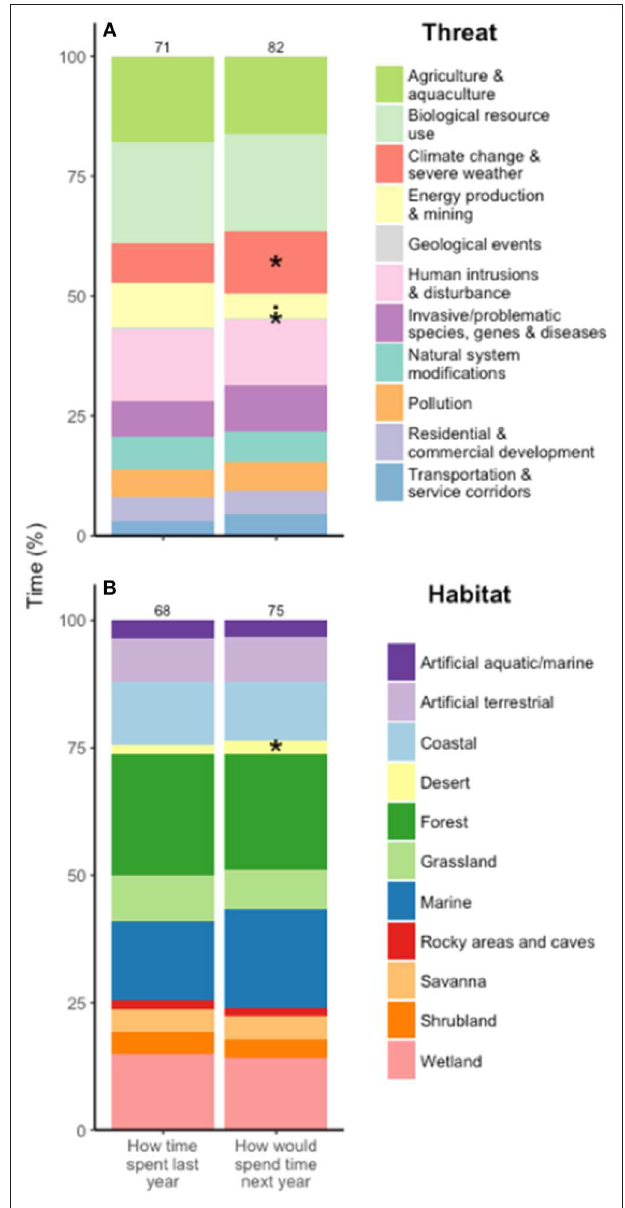
FIGURE 4 | How conservation practitioners spent their time last year and how they would spend it next year, for Threats (A) and Habitats (B) . Survey responses are from nine leading internationally-focussed biodiversity conservation organizations (see Methods in section Time analysis). “Last year” is 01/08/2017–31/07/2018. “How would spend time next year” assumed that conservation practitioners were acting in conservation’s best interest and that funding and job requirements were not an object. The *indicates a significant (Paired Wilcoxon test, p < 0.05) and. near significant ( p = 0.07) difference between “last year” and “next year” for threats or habitats. The number of individual responses to each question is shown on top of each